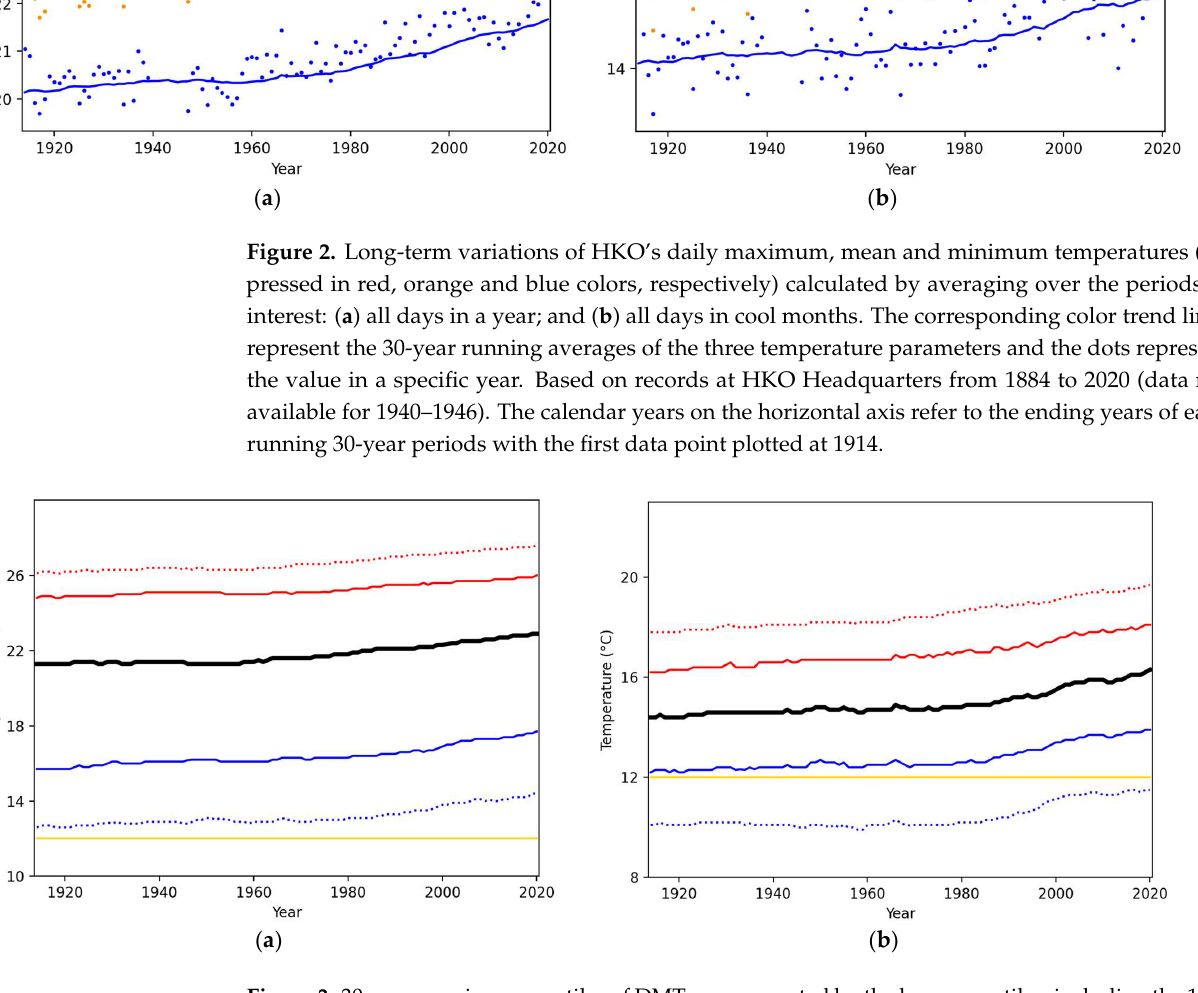
Figure 3. 30-year running percentiles of DMT as represented by the key percentiles, including the 10th (blue dotted), 25th (blue solid), 50th (black solid), 75th (red solid) and 90th (red dotted) percentiles over the periods of interest: ( a ) all days in a year and ( b ) all days in cool months. Data range and plotting convention are same as those in Figure 2. The horizontal yellow line marks the threshold temperature at 12.0 °C for cold weather.